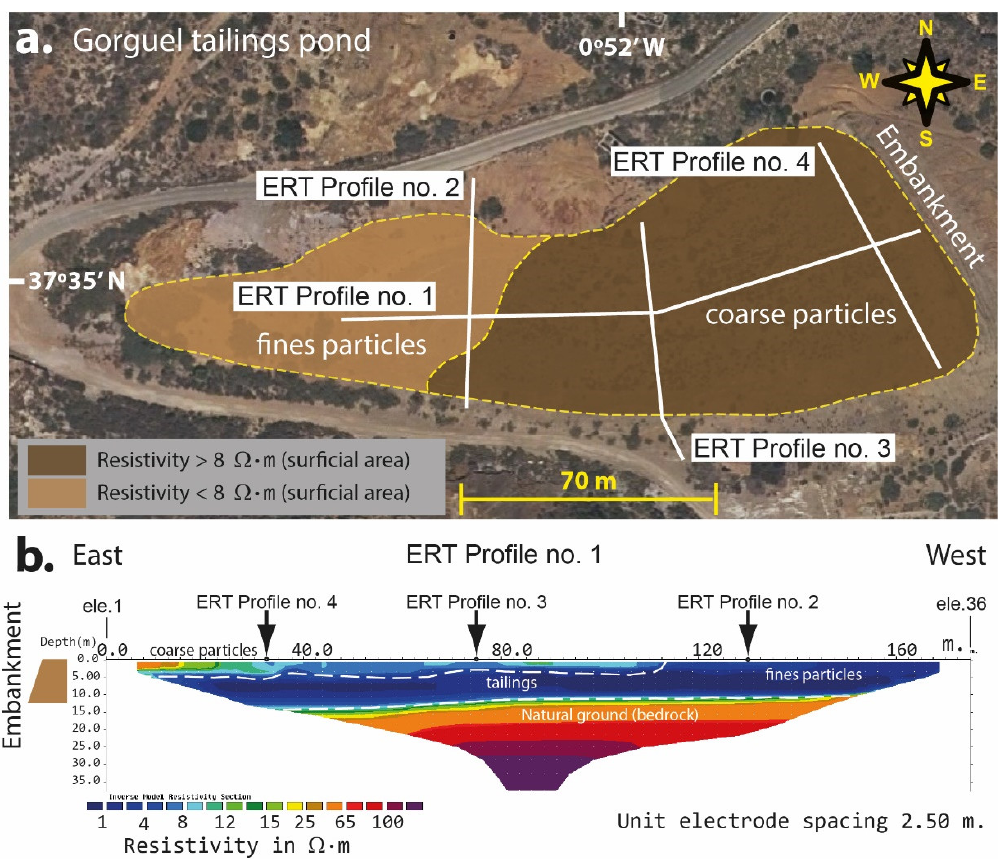
Figure 3. Different surficial zones according to their electrical resistivity values. ( a ) Set up of four ERT profiles on the tailing pond; ( b ) Electrical section from ERT profile no. 1.